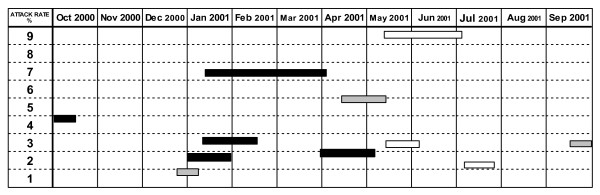
Possible infectious GI outbreaks among ships deployed to the Persian Gulf AOR during October 2000 – September 2001.  Destroyer  Aircraft Carrier  Amphibious Assault/Combat Support